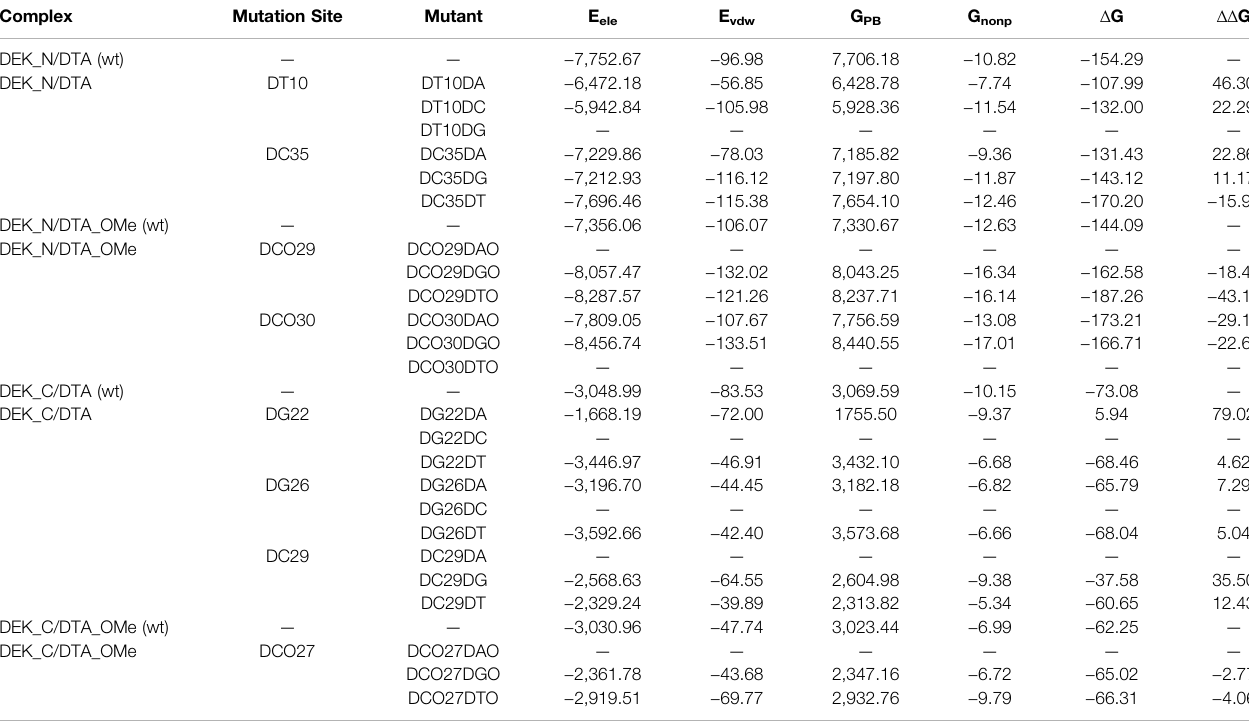
TABLE 3 | Energy distribution of the wild type complexes and the corresponding mutants. ΔΔ G means the energy difference between each mutant and its corresponding wild type (unit: kcal/mol). Complex Mutation